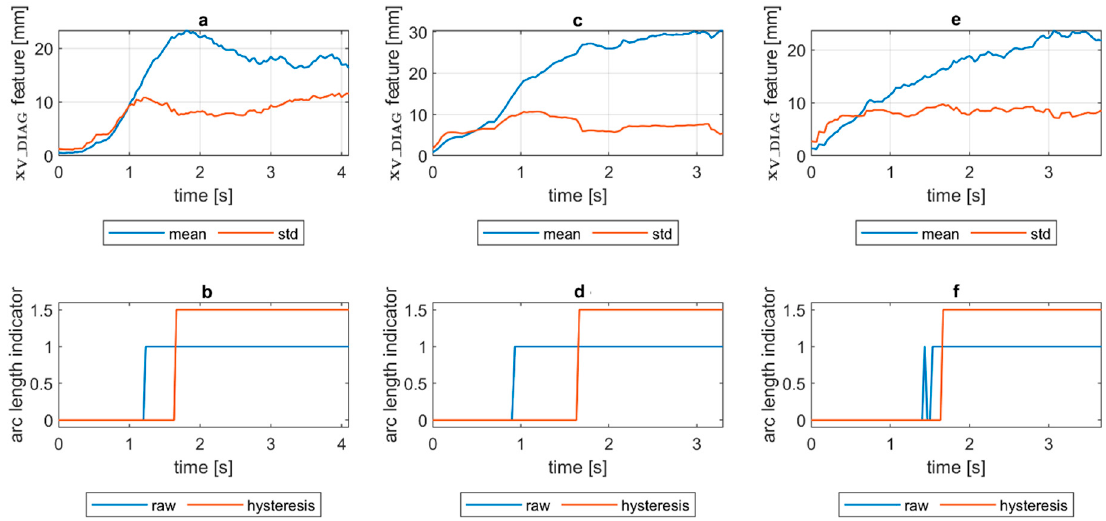
Figure 8. Change in arc length for DC(+) polarity on the test stand and the arc length indicator z ALI for welding current: ( a,b ) 110A; ( c,d ) 130A; ( e,f ) 150A